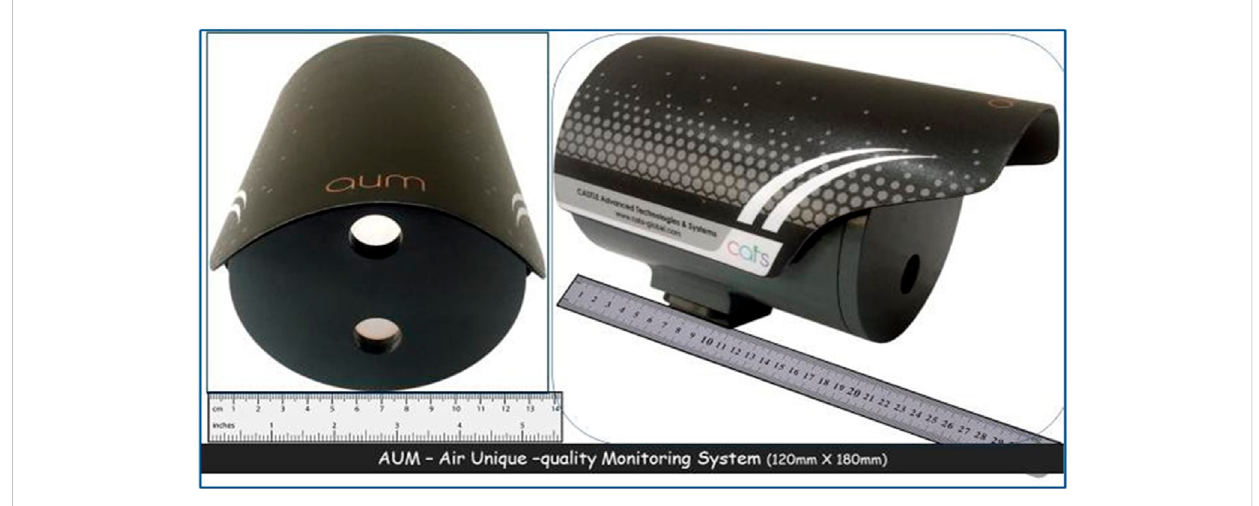
FIGURE 1 AUMphotonicsystem[comprisingofacontinuouswavelaserlightsourceatthebottomonthefrontside,toilluminatethetargetvolumeofair,and, apositionsensingphotodetectoratthetoponthefrontside,todetectthebackscatteredlaserlightfromthetargetvolume.Optical fi ltersinfrontofboth laser source and the photodetector ensures that only the particular wavelength of light from the source passes through and falls back on the photodetector after scattering from microbes in target volume of air [Picture adopted from Tatavarti, 2021